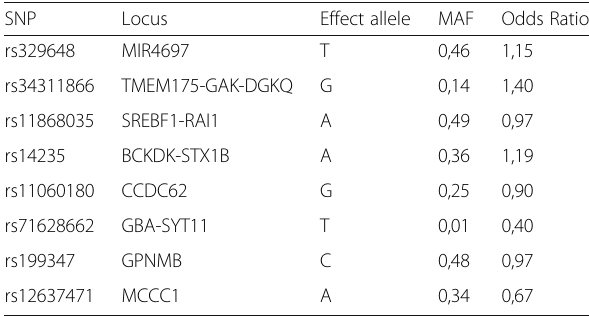
The number of effect alleles (coding 0 = no effect allele, 1 = one effect allele and 2 = two effect alleles) and the weighting of the respective SNP with the effect size of the effect allele, measured with the ln of the odds ratio, are incorporated into this score from each risk SNP. If the calculated risk score for a patient exceeds a threshold value of + 0.30, this patient is assigned to the omics+ group. If a patient has a risk score of less than − 0.30, an assignment to omics- is made. Patients with a risk score between − 0.30 and + 0.30 do not belong to one of the two “ extreme ” omics groups. These patients are not included in the study if they Table 2 SNPs taken a genome-wide association study on PD are not heterozygous, homozygous or compound heterozy- used for stratification of patients (omics+/ − groups) gous for mutations in the Parkin or PINK1 gene. In patients SNP Locus Effect allele MAF Odds Ratio who are assigned to one of the two omics groups, muta- rs329648 MIR4697 T 0,46 1,15 tions in the PINK1 or Parkin gene will be excluded. The rs34311866 G 0,14 1,40 thresholds as mentioned above were determined to repre- A 0,49 0,97 sent the 20 and 80% quantiles in our cohorts in which the A 0,36 1,19 score has been established. A number of the study partici- pants ’ samples will be genotyped twice in order to ensure CCDC62 G 0,25 0,90 the reproducibility of genotyping. In this way, the agree- rs71628662 T 0,01 0,40 ment can be determined SNP-specifically and overall. The rs199347 GPNMB C 0,48 0,97 intra-class correlation coefficient is used as a measure of MCCC1 A 0,34 0,67 agreement. It is suspected that the four groups differ in the SNPs were taken from the study of Nalls et al. [6]. Only SNPs were taken into degree of mitochondrial dysfunction, with increasing dys- account with an in silico annotation to mitochondrial homeostasis. SNP: single function from omics- via omics+ and P+ to P++. nucleotide polymorphism. MAF: mean allele frequency